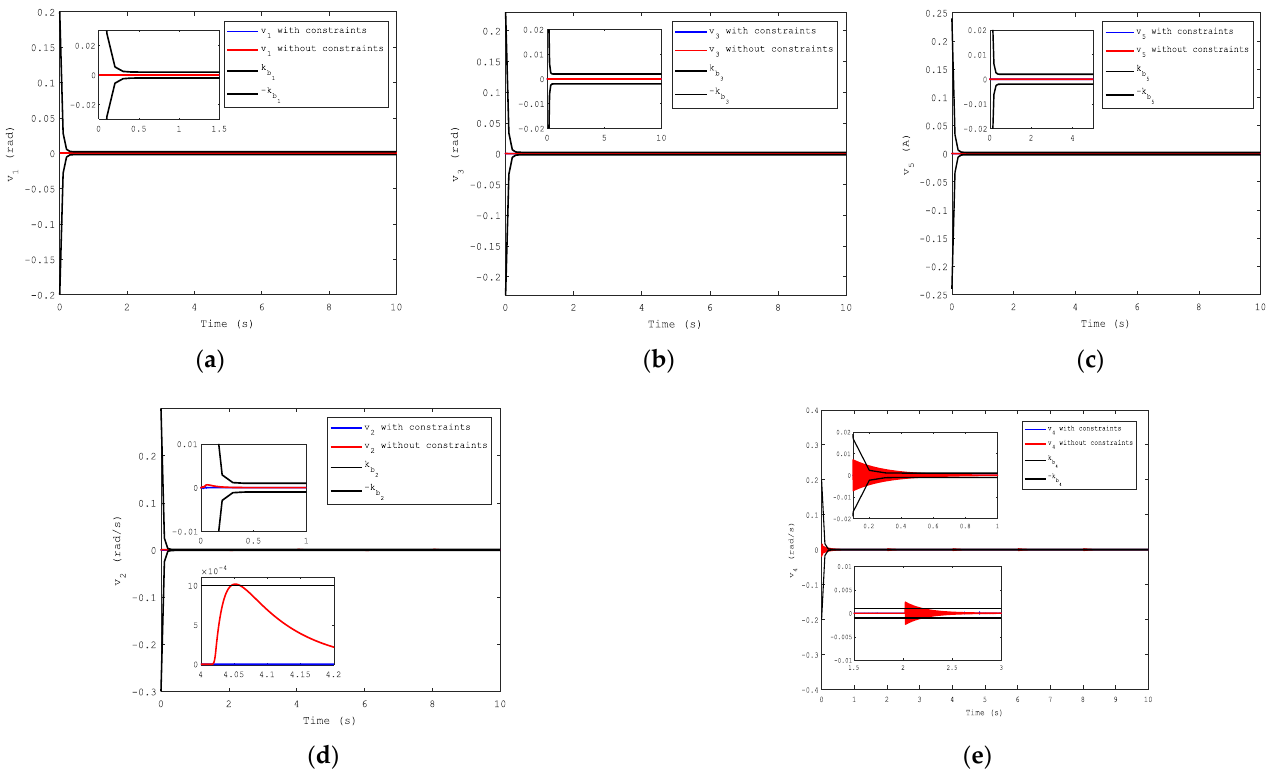
Figure 10. Compensated tracking errors: ( a ) for the first subsystem; ( b ) for the third subsystem; ( c ) for the fifth subsystem; ( d ) for the second subsystem; ( e ) for the fourth subsystem.